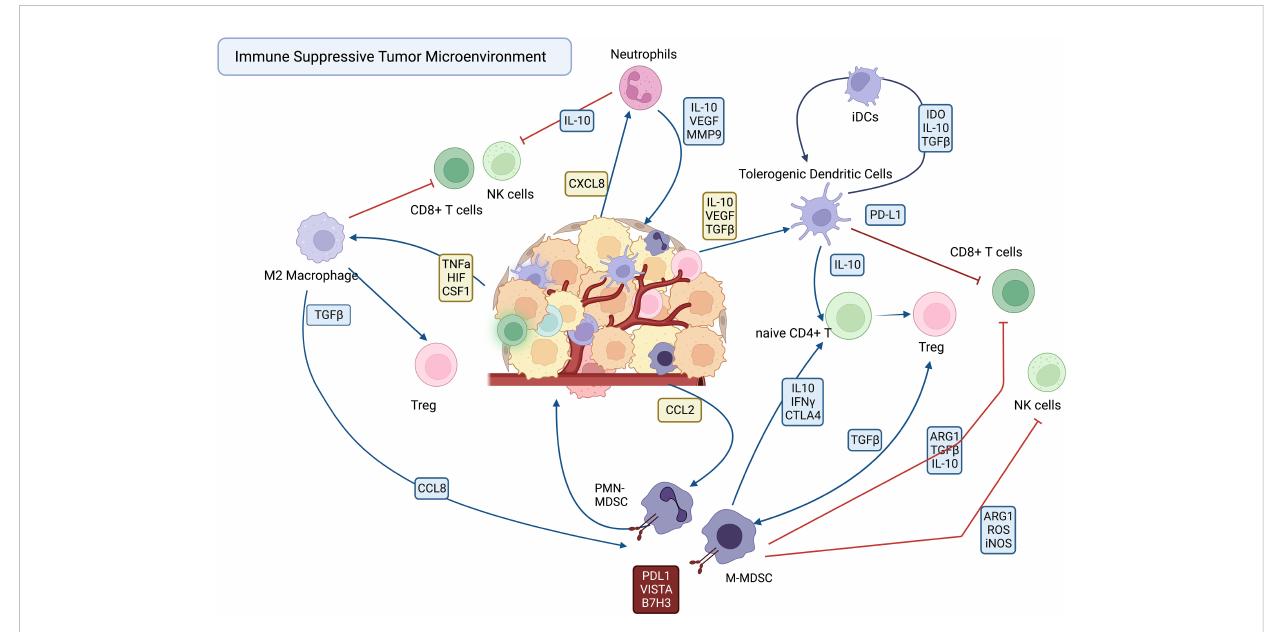
FIGURE 1 Cellular interactions in the immune suppressive tumor